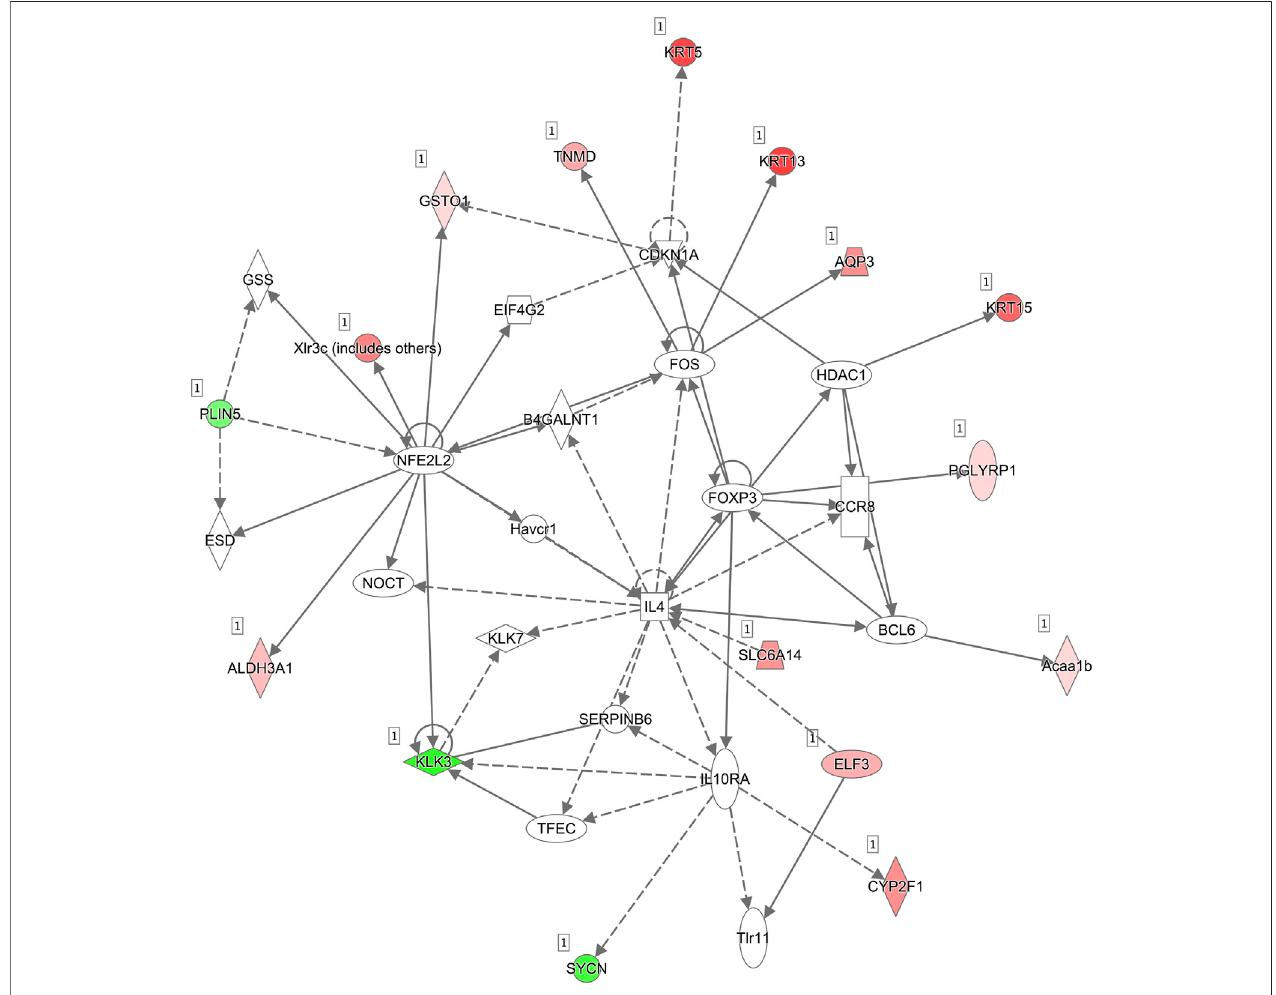
FIGURE 6 | Molecular interaction networks. The most signi fi cant biological network of “ Cell Morphology, Embryonic Development ” was generated. Upregulated mRNAs are indicated in red, while downregulated mRNAs are in green. Solid lines represent the direct function, while the dotted lines represent the indirect function.